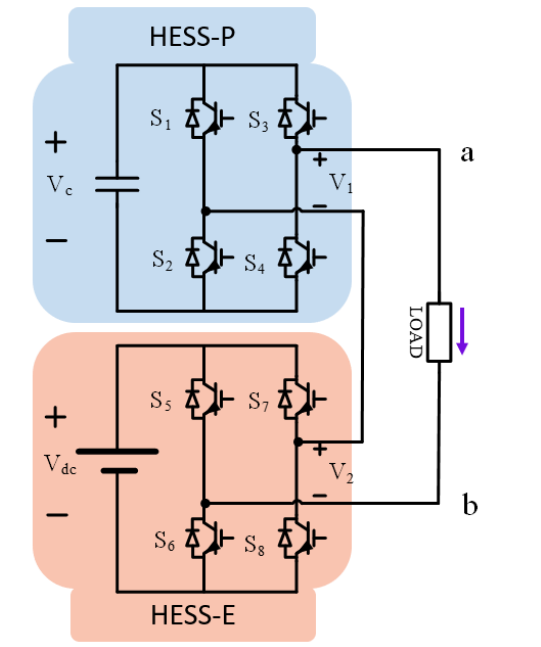
Figure 2. Single-phase two-cell asymmetrical hybrid CHB